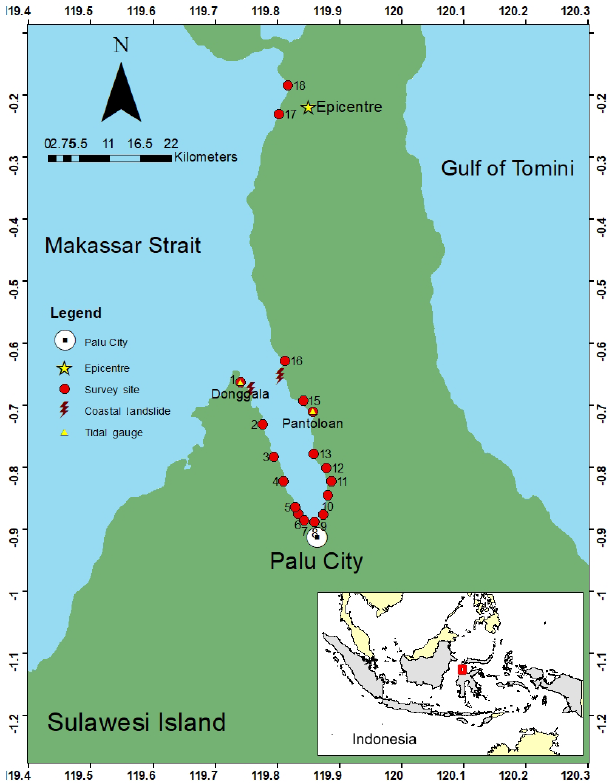
Figure 1. Survey area of Palu Bay located on Sulawesi island. A camera in a moving car was used to record the tsunami-affected area following the Trans-Sulawesi Highway parallel to Palu Bay coastline from Site 1 to Site 18. Tidal stations were located at Site 1 (Donggala) and Site 14 (Pantoloan). Coastal landslides were de- tected at Site 1 (Donggala) and Site 16